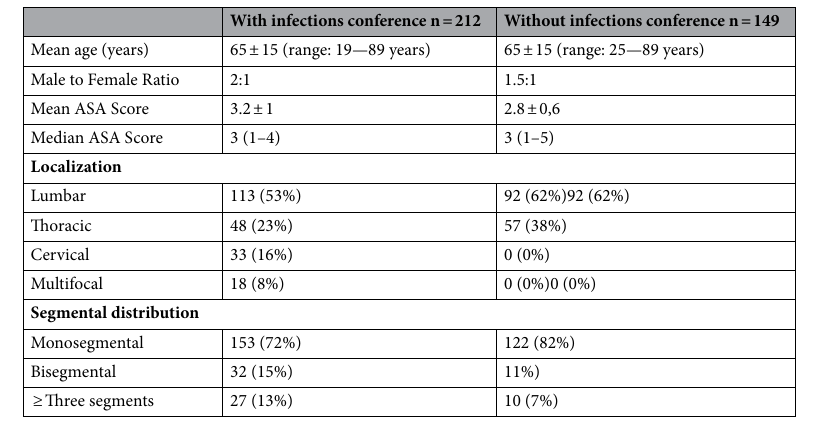
Table 1. Patient characteristics, ASA score as well as spinal localization and distribution in both treatment groups. The ASA Score in both groups differed significantly ( p < 0.001).